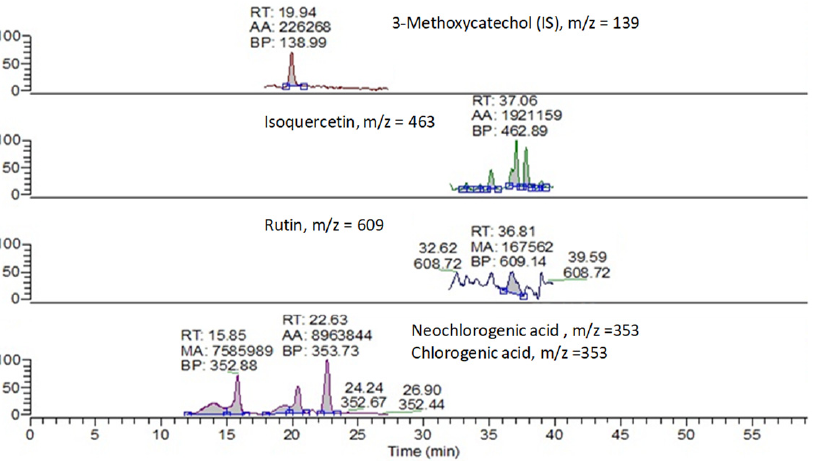
Figure 1. HPLC-ESI-MS chromatogram of hydroalcoholic extracts (MeOH/H 2 O; 80:20%, v/v ) of sample 1S-VN.